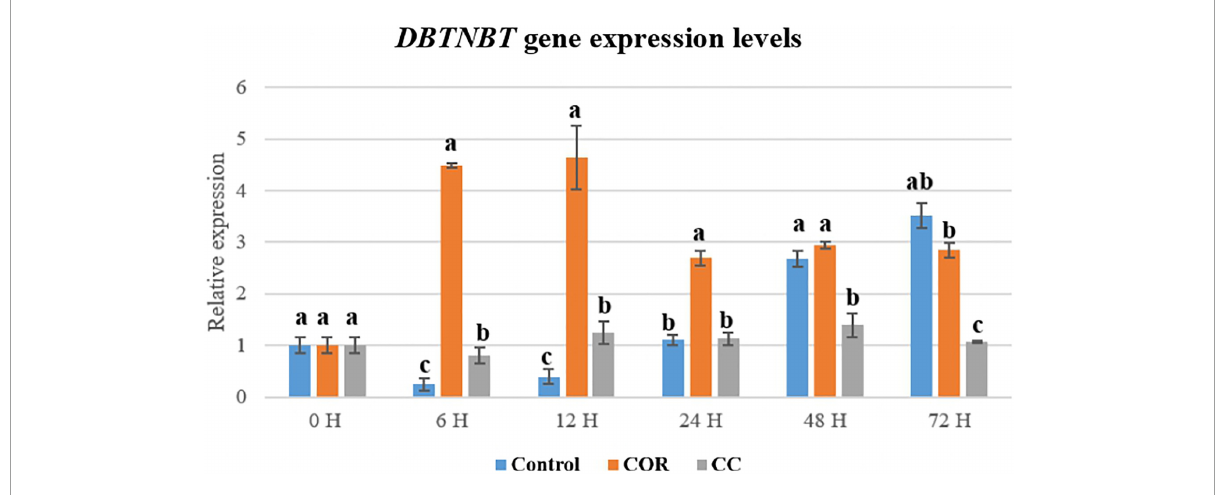
FIGURE12 Relative expression of the DBTNBT gene in T. baccata cell cultures grown in Control conditions and elicited with 1 mM coronatine (COR) or 1 mM coronatine + 50 mM methyl- β -cyclodextrins (CC). Values presented are means ± SD ( n = 3). Values followed by different letters are significantly different ( P ≤ 0.05) according to Tukey’s honestly significant difference